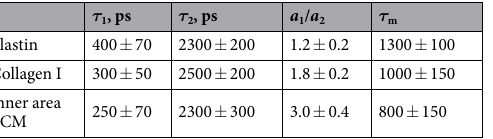
Table 1. Fluorescence decay parameters obtained for the ECM components in the papillary